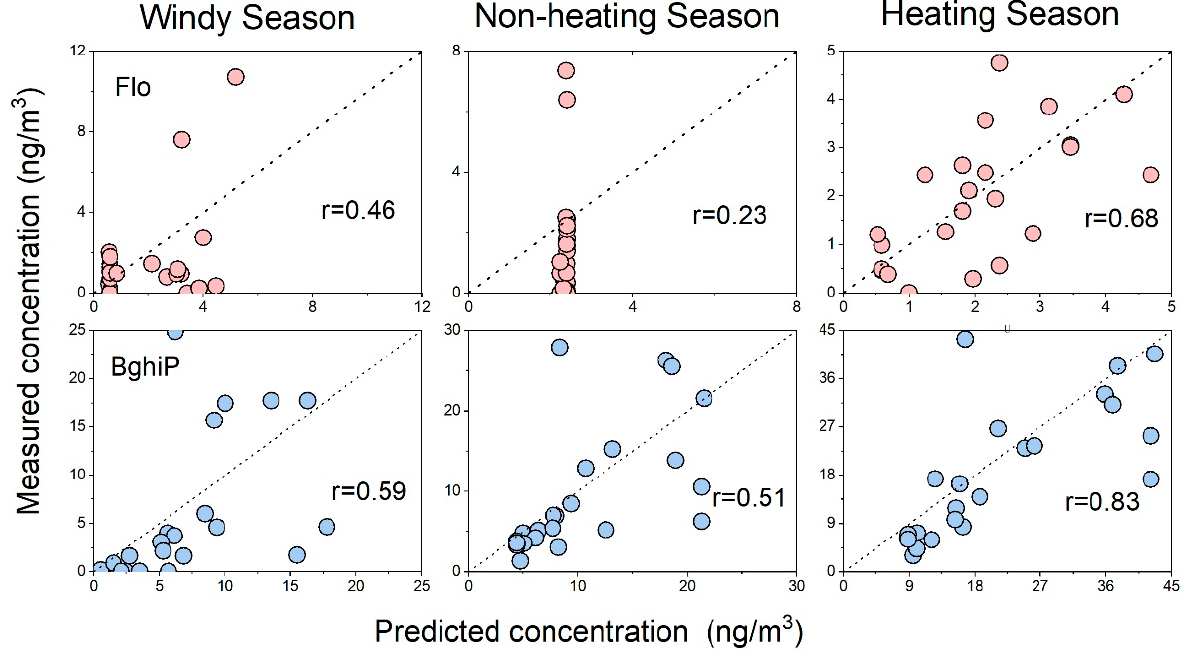
Figure 4. Results of leave-one-out cross-validation for particulate PAHs LUR models: predicting concentrations ( x -axis) against measured concentrations ( y -axis) for LUR models.